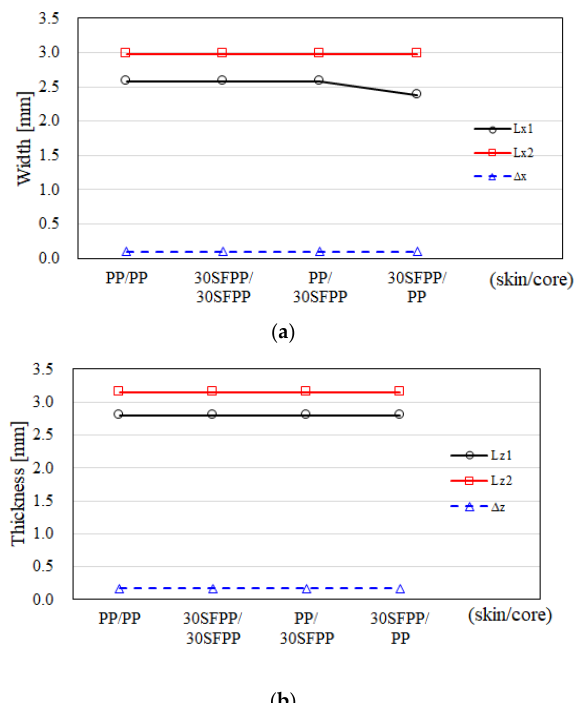
Figure 8. The dimension variation of the CSC structure for different material combinations for skin and core arrangement effects using simulation.